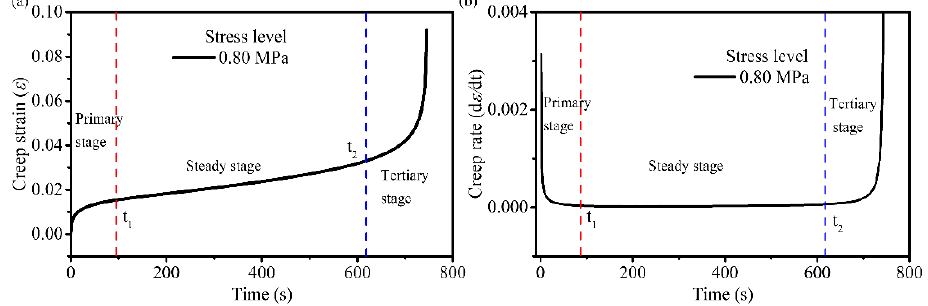
Figure 6. Schematic of the three stages ( a ) curve of three stages of creep, ( b ) curve of creep rate of asphalt mixture.